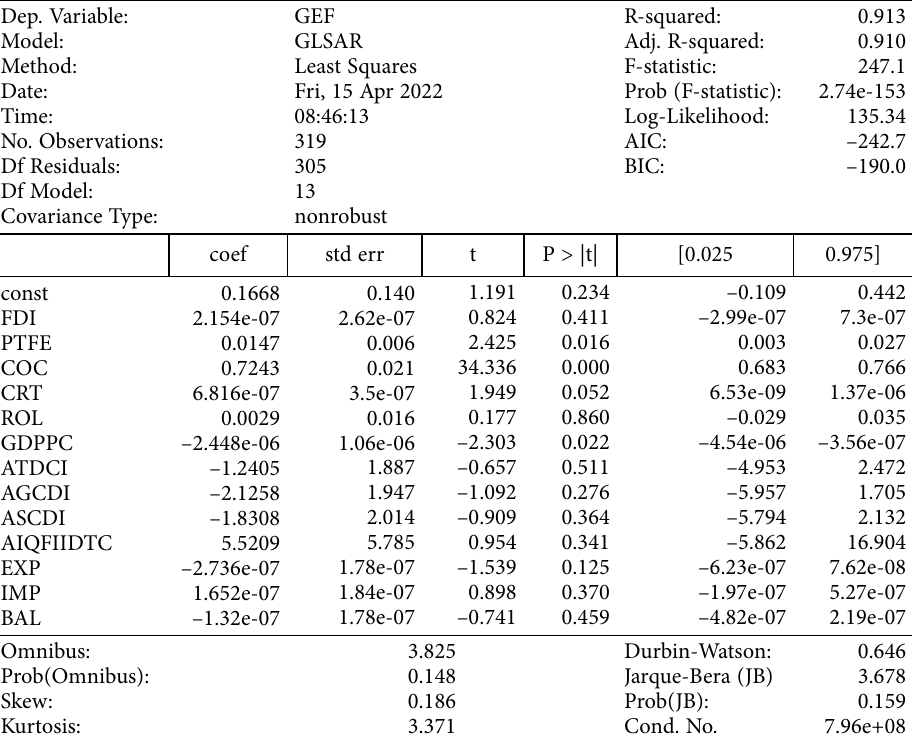
Table 10. GLSAR regression results – Part 3 (source: own processing using Python 3.0